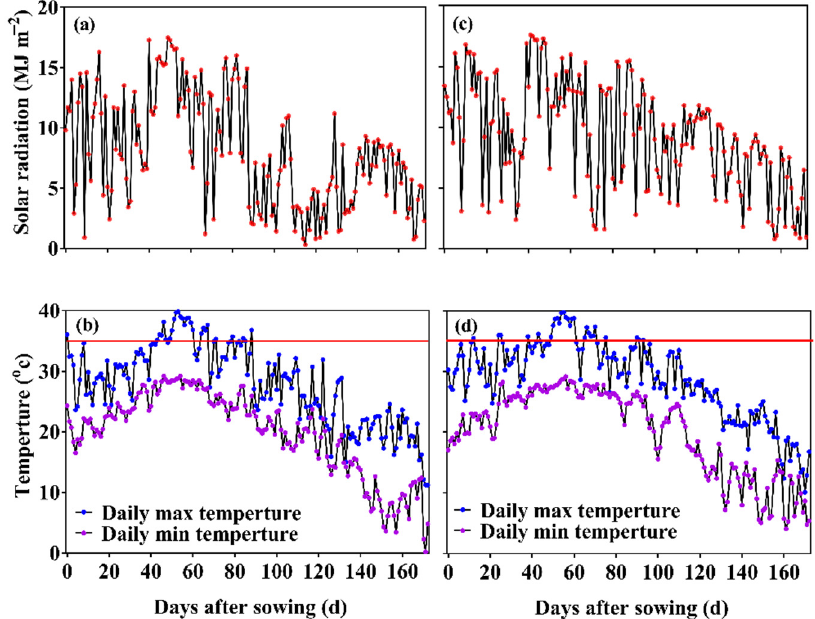
Figure 1. Daily photosynthetically active solar radiation ( a , c ) and temperature ( b , d ) during the entire growth duration in 2017 ( a , b ) and 2018 ( c , d ). The red horizontal lines in ( b , d ) denote high temperature stress.